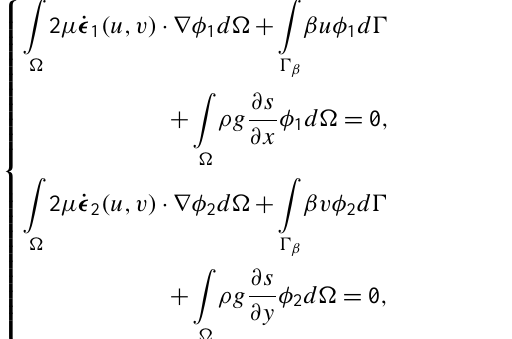
∗ The symbol k in the table denotes kmm 1 , i.e., k = kmm − 1 = 10 3